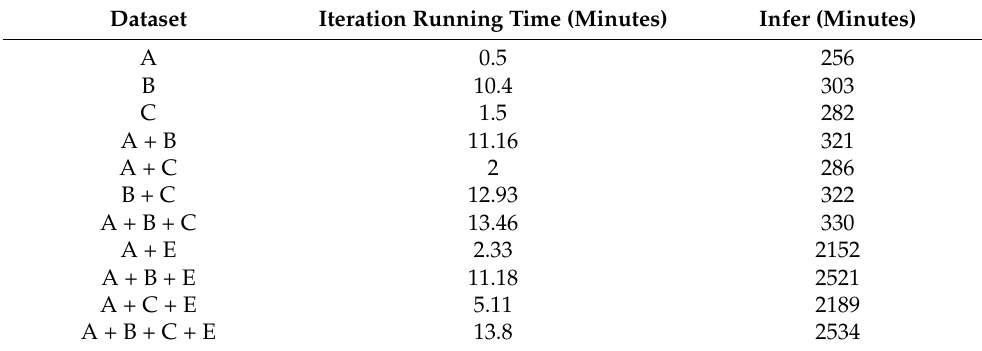
Table A1. Average running